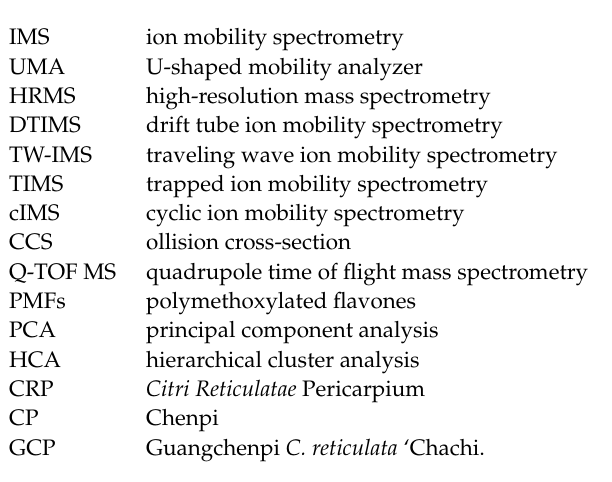
Figure S5: MS spectra (top) and drift tube spectra (bottom) of tangerine and sinensetin by